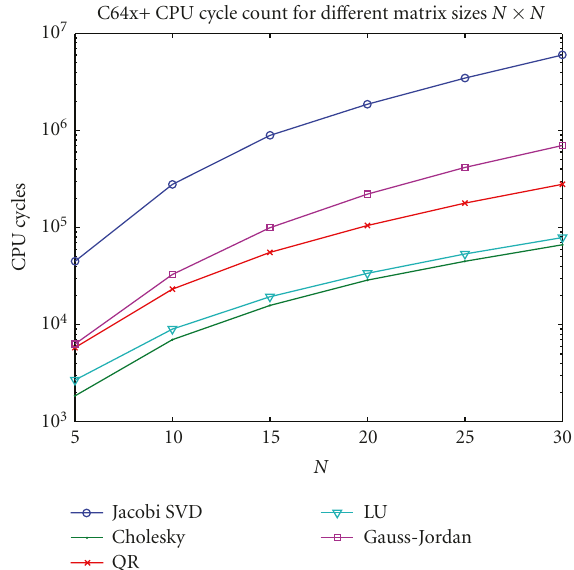
Figure 11: Number of C64x+ CPU cycles required to calculate se- lected linear algebra algorithms in fixed point arithmetic for di ff er- ent size